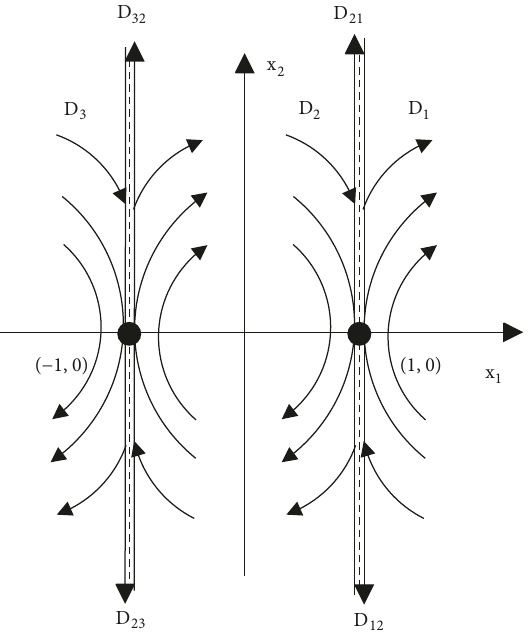
Figure 5: Sliding dynamics.